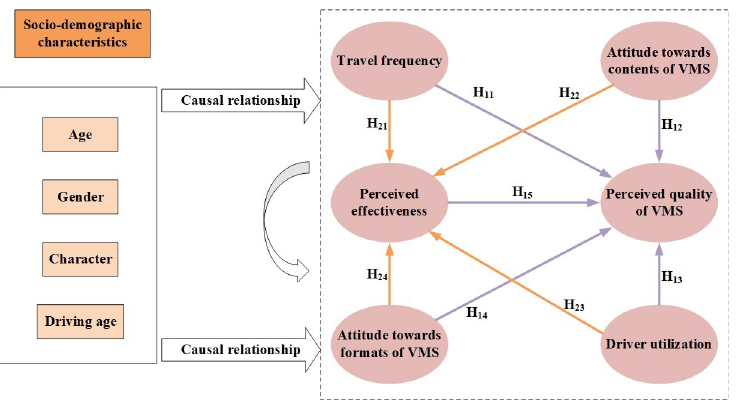
Fig 2. Framework and research